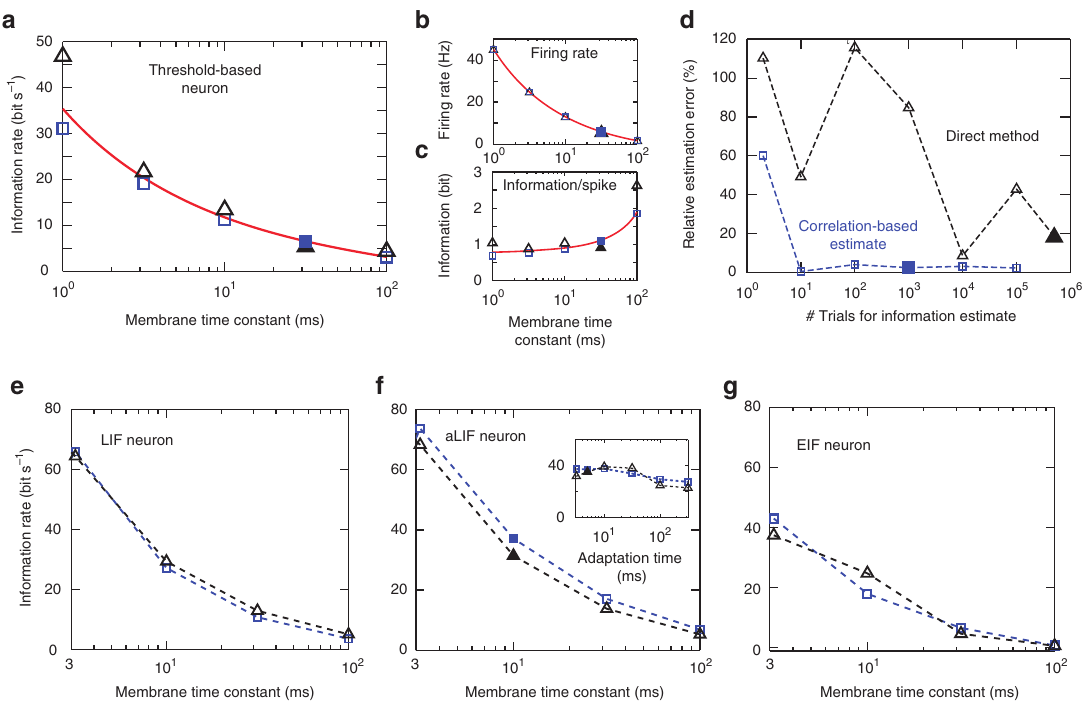
Figure 6 | Correlation-based information estimates outperform the direct method. ( a ) Correlation-based information estimates (blue squares) and exact analytical values provided by the correlation theory (red line) agree with the direct method 16 (black triangles) across two orders of membrane time constants in the threshold-based model. The corresponding firing rate and information per spike are in b , c , respectively. ( d ) Convergence to the exact information values for both correlation-based estimate and the direct method is shown for the selected data points (filled symbols) from a . We find that the correlation-based information estimate requires orders of magnitude smaller trial counts to achieve comparable accuracy and shows greater numerical stability. ( e – g ) We confirm the agreement between the correlation-based information estimate and the direct method in three additional spiking models: leaky integrate-and-fire neuron model (LIF, e ), adaptive integrate-and-fire neuron model (aLIF, f ) and the exponential integrate-and-fire model (EIF, g ). ( f ) Inset: we vary the adaptation constant t o across two orders in magnitude in the aLIF model, to demonstrate that our correlation theory applies to spike trains with complex internal structure that is not simply induced by the input. Parameter values as in Table 1 and spiking dynamics as described in the Methods